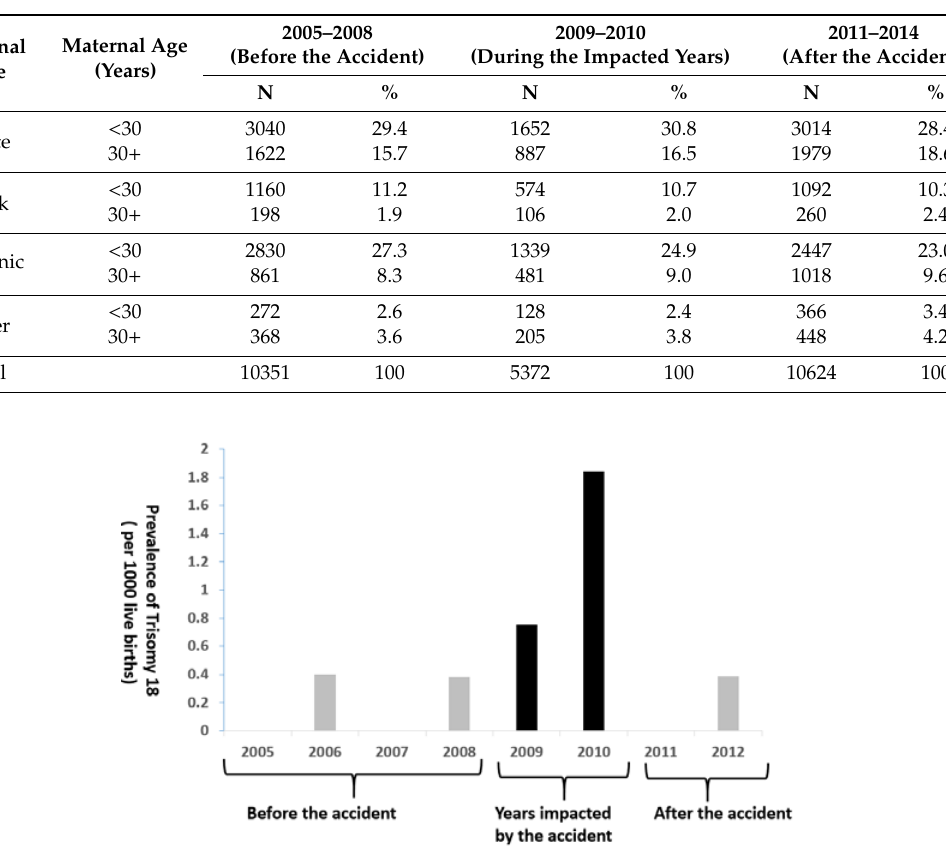
Table 1. The distribution of live births by maternal race and age in Brazos County, Texas, 2005–2014.